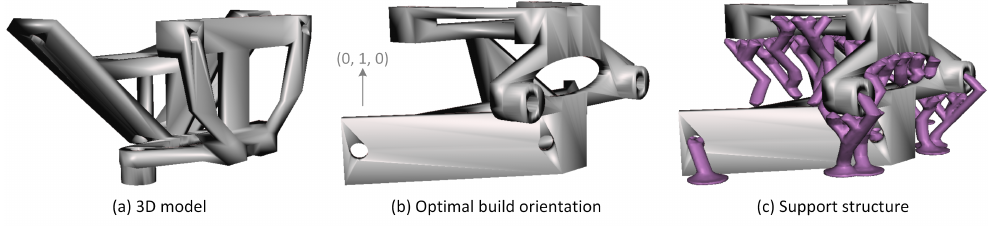
Figure 8. 3D model, optimal build orientation, and support structure of an LPBF part.